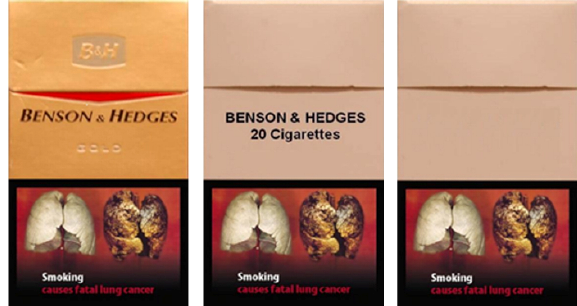
Figure 2. Example of GWLs applied to branded, plain and blank cigarette packages. Adapted from Maynard and colleagues